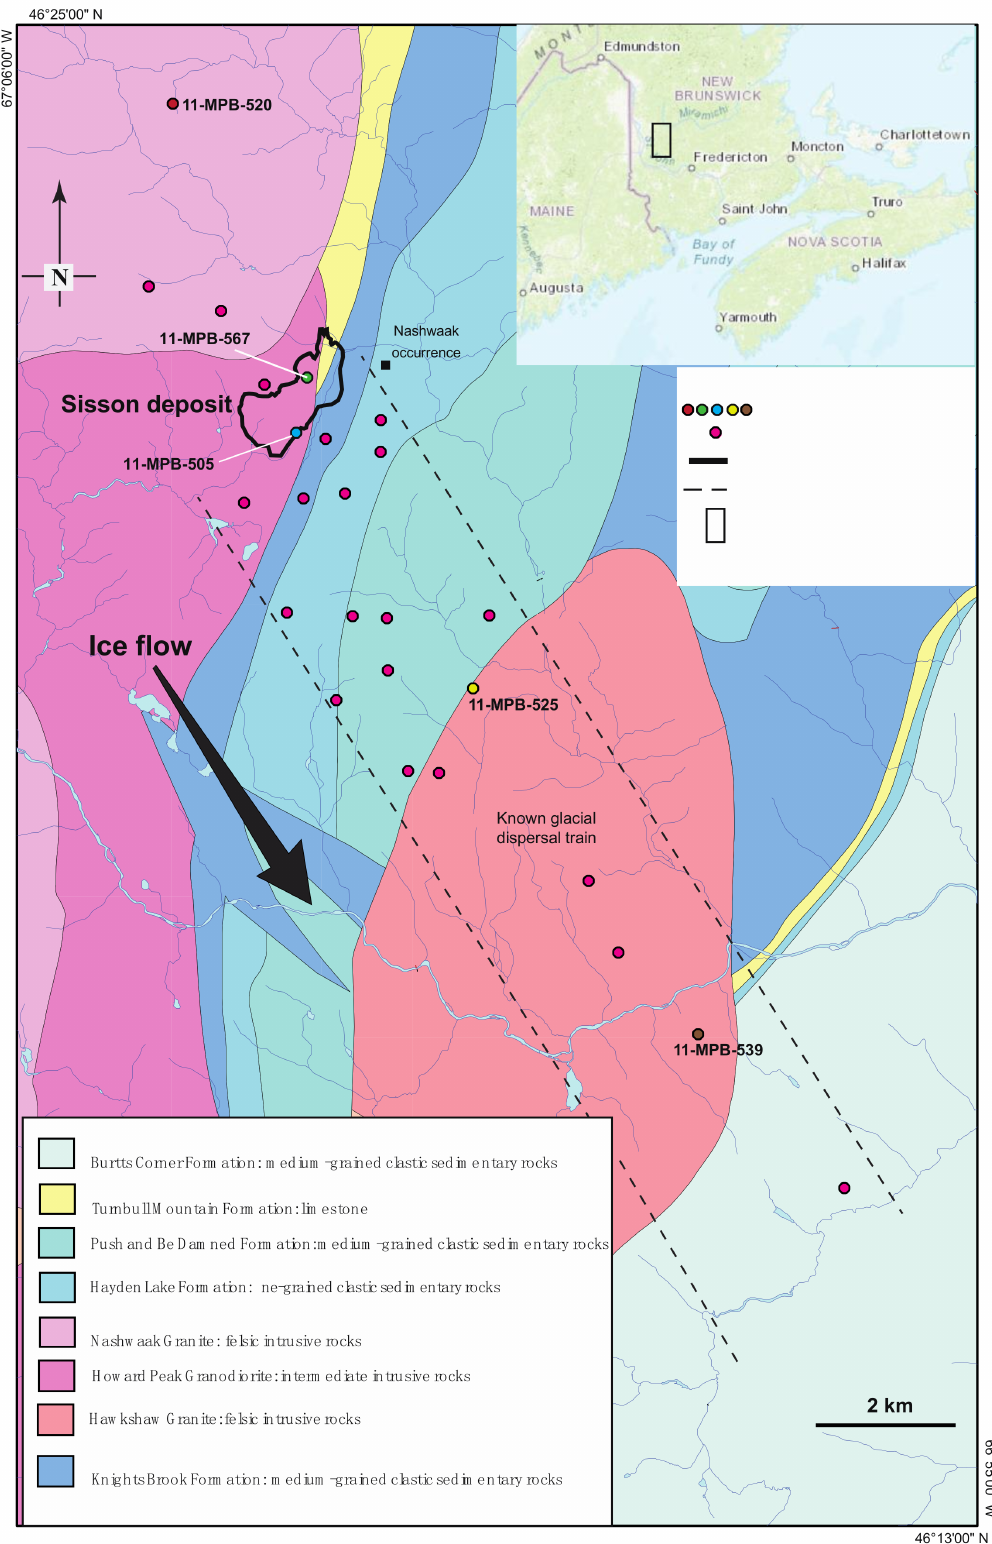
Figure 1. Location of the five studied till samples (yellow dots) and the geology surrounding the Sisson granite-hosted W-Mo deposit, New Brunswick. Red dots indicate location of till samples collected by the Geological Society of Canada in 2011 [20]. Modified from McClenaghan et al.